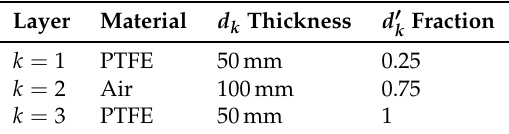
Figure 3. Coaxial cell [65] with the type N connector filled with PTFE ( k = 1 and k = 3) and air ( k = 2); all dimensions in mm. Table 1. Experimental setup for coaxial cell